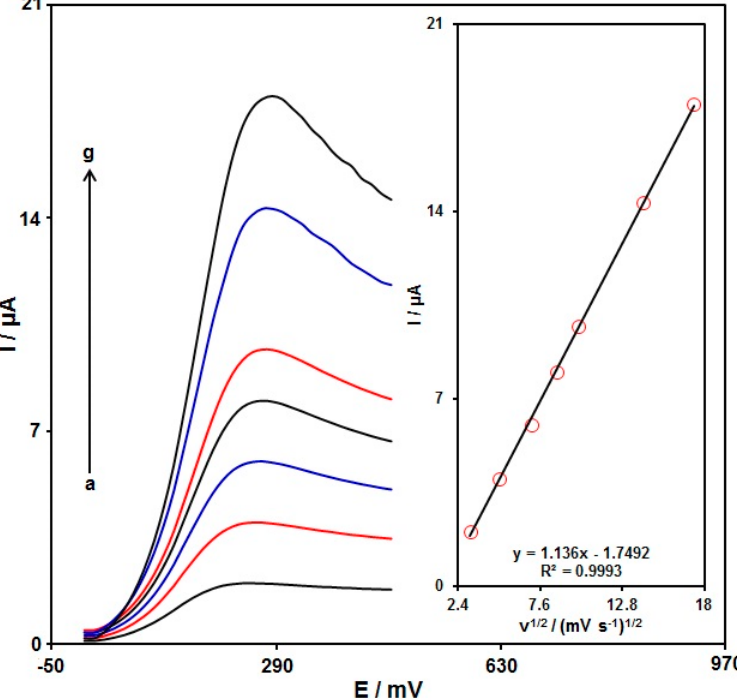
Figure 7. LSVs captured for the oxidation of morphine (100.0 µM) on the graphene-Co 3 O 4 /SPGE under variable scan rates (a–g: 10, 25, 50, 75, 100, 200, and 300 mV/s); Inset: the correlation of Ipa with ∪ 1/2 .